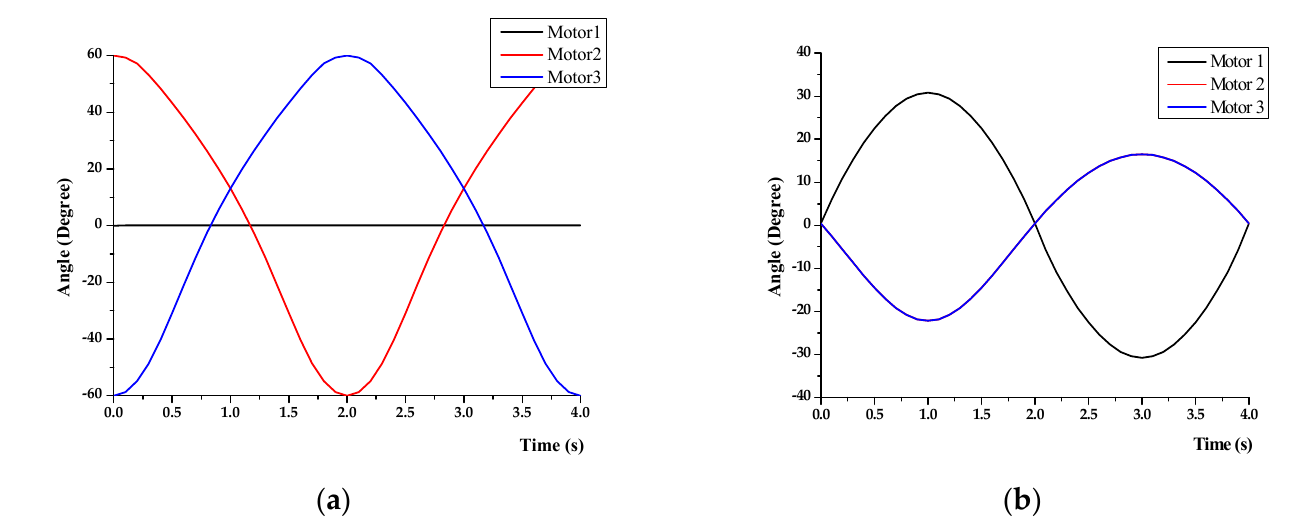
Figure 24. The ( a ) roll ( b ) pitch motor motion input trajectory.